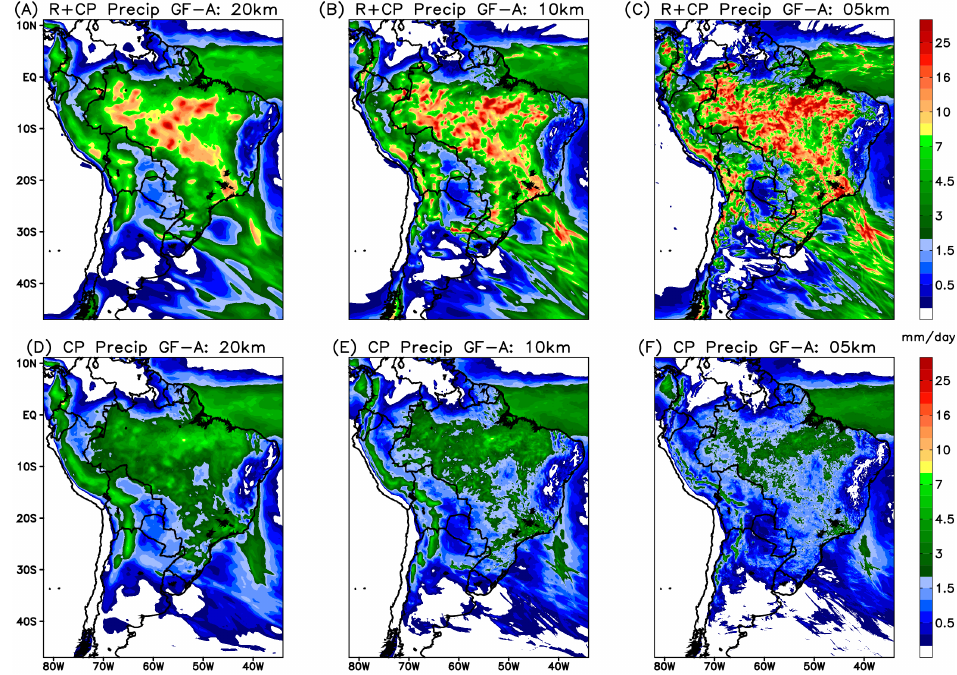
Figure 5. Averaged precipitation rates over 15 runs for total precipitation ( A , B , and C ) and convective (nonresolved) precipitation rates ( D , Figure 5:Averaged precipitation rates over 15 runs for total precipitation (A, B, and C) and convective (non- resolved) precipitation rates (D,E, and F), using GF-A and horizontal resolutions of 20km (A an D), 10km (B and E , and F ), using GF–A and horizontal resolutions of 20km ( A and D ), 10km ( B and E ) and 5km ( C and F ). Units are mm/day. E) and 5km (C and F). Units are mm/day.